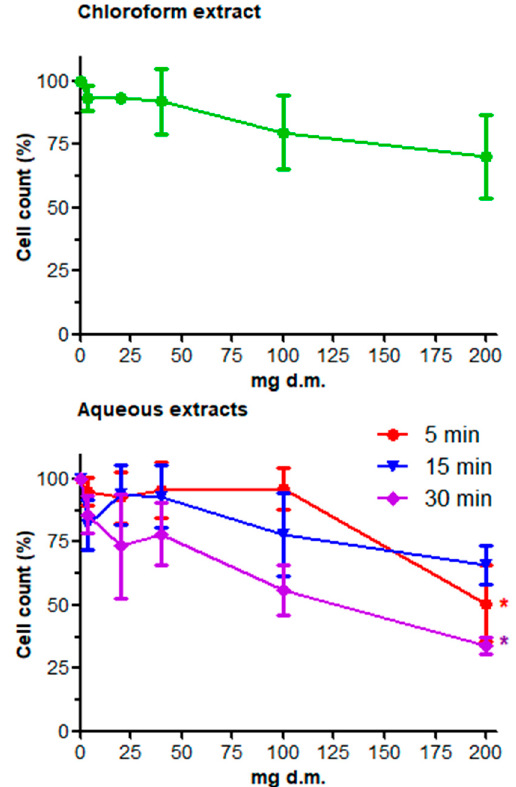
Figure 1. Effects of scalar concentrations of S. vulgaris chloroform and aqueous extracts on HepG2 cell viability expressed as percent of negative control (taken as the unit, 100%). The results of each experimental set are summarized as the mean (±SEM) of three independent experiments. Statistical analysis: * indicates statistically significant differences ( p < 0.05) compared with the negative control, one-way ANOVA followed by Dunnett’s post hoc analysis. Cell viability (%) after treatment with the positive control (1% Triton-X-100): 34.94 ± 2.24.